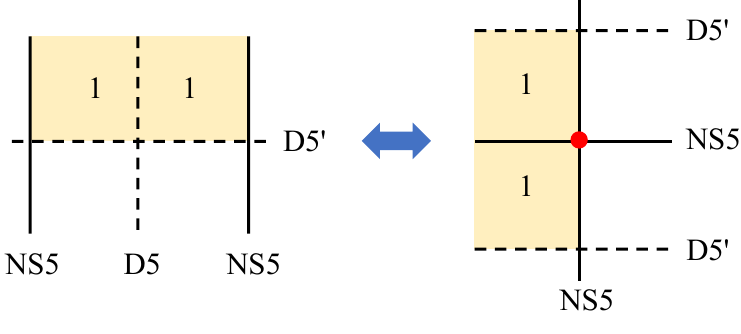
, D (cid:31) ) for SQED 1 and its dual Neumann D (cid:31)